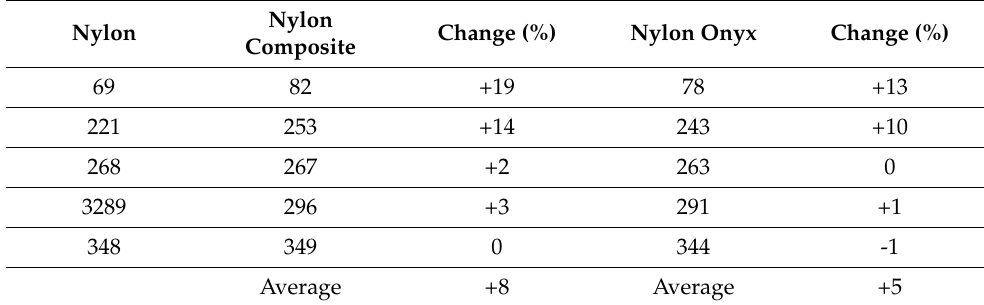
Figure 12. MAC analysis results for re-entrant lattice structure: Side-clamped. Table 13. First five natural frequencies of re-entrant lattice structure in the bottom-clamped boundary condition and the paired modes when the material of vertical parts of re-entrant lattice structure changed to composite or onyx.